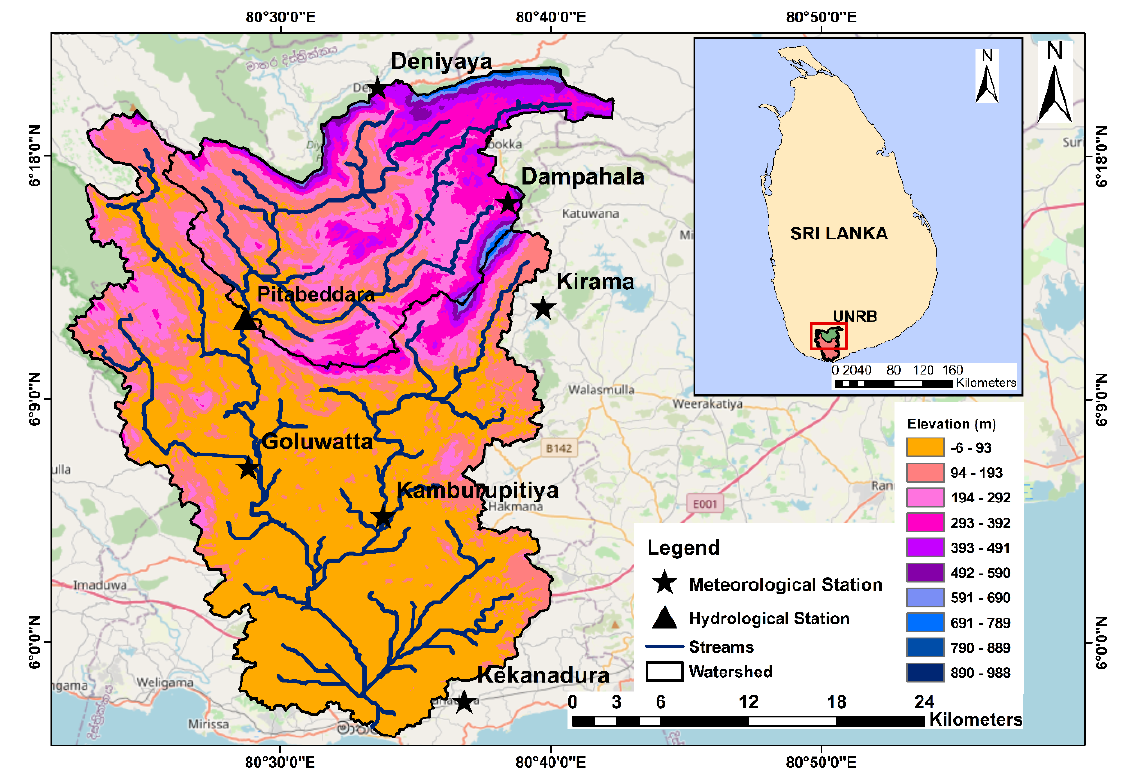
Figure 1. Location map of the Nilwala River Basin with its hydrological and meteorological stations.